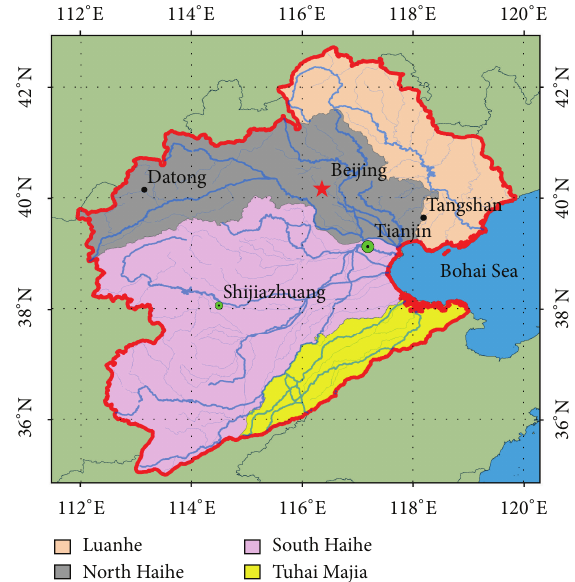
Figure 1: Location of the Haihe River basin with its main